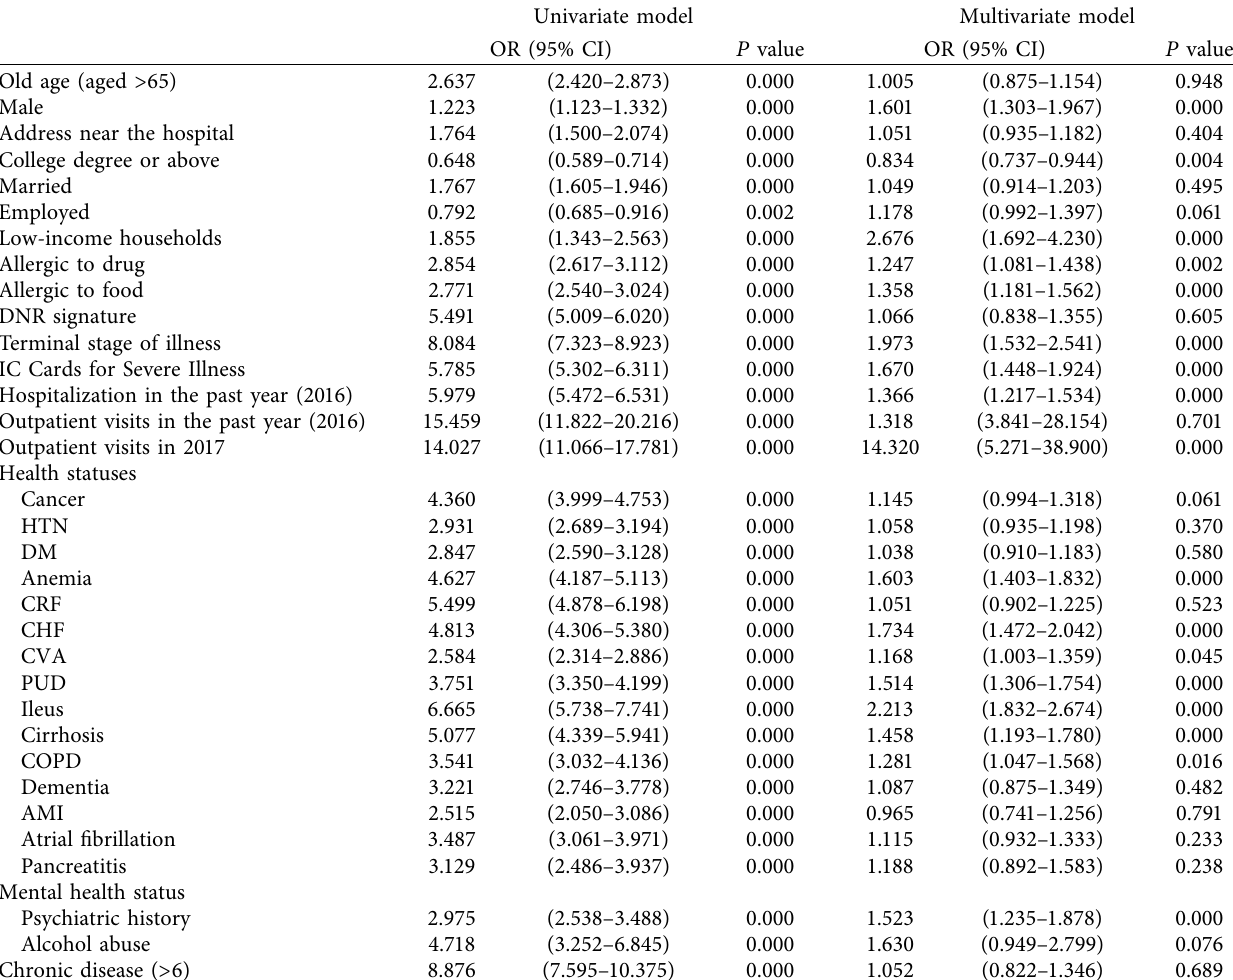
Table 2: Factors related to repeated use of emergency services.